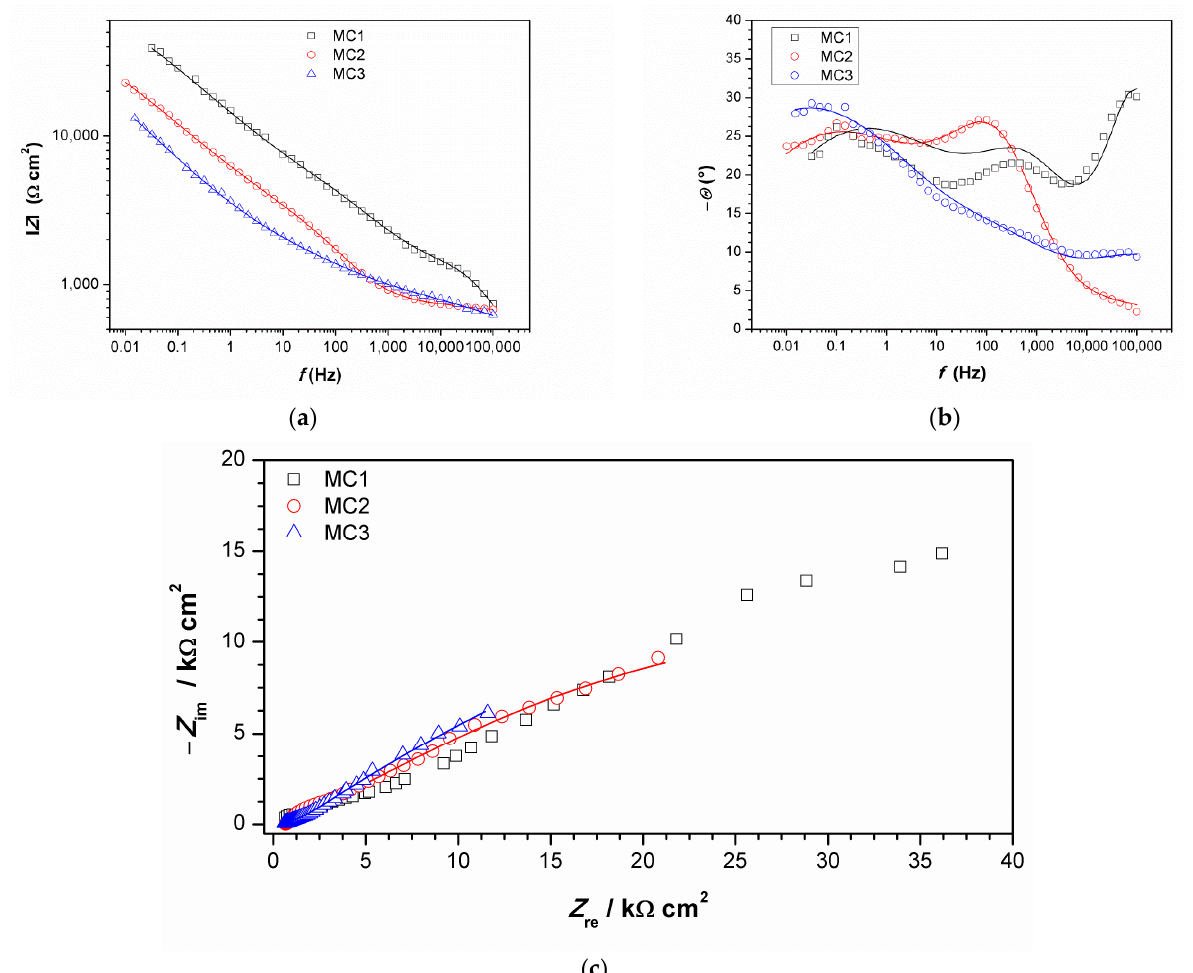
Figure 11. Impedance spectra obtained on MC: ( a ) impedance modulus Bode plot, ( b ) phase angle Bode plot, and ( c ) Nyquist plot. Symbols represent measured and lines fitted data.